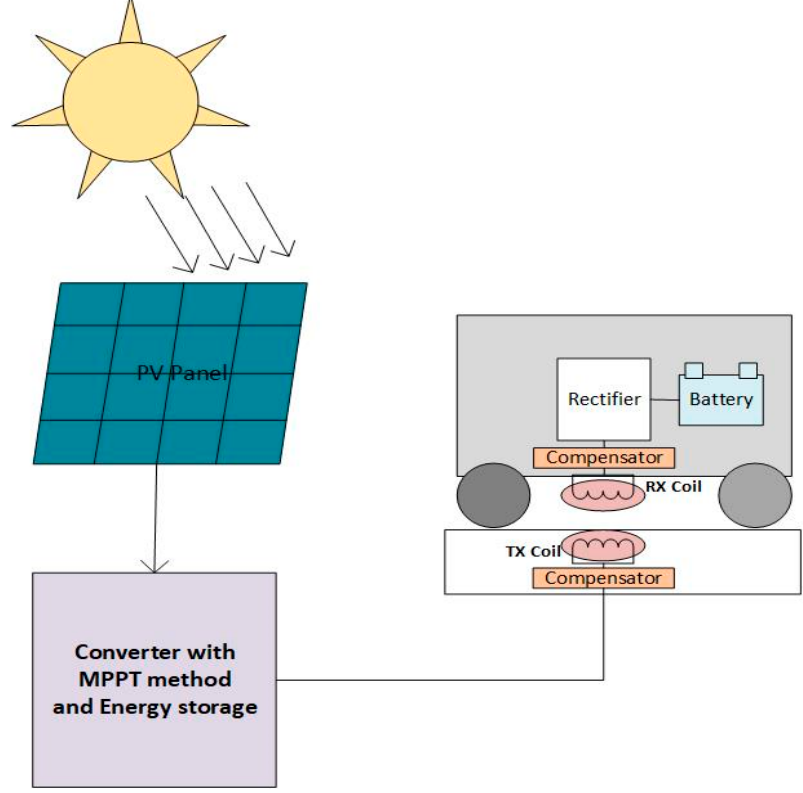
Figure 8. Static wireless electric vehicle charging system schematic.